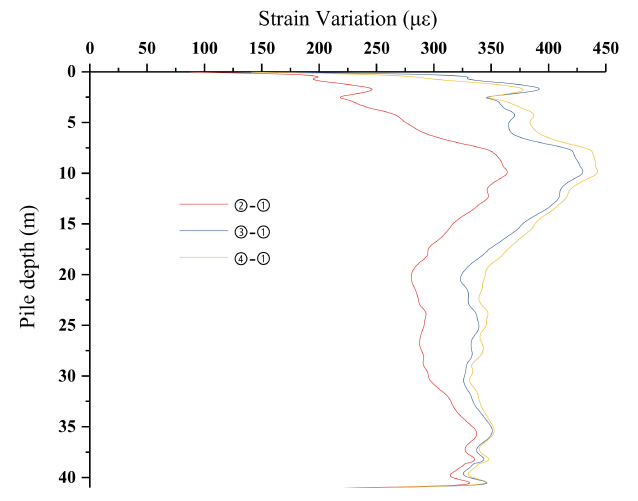
Figure 8. Average of strain variation curve of fiber